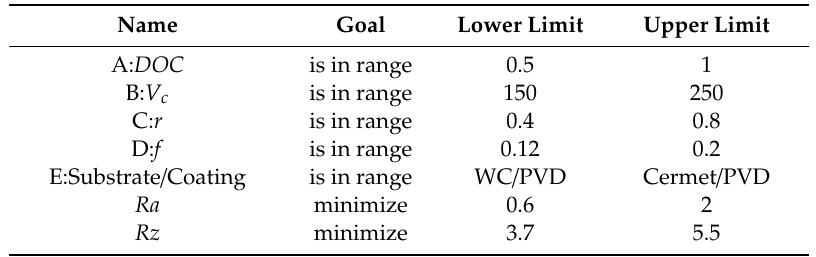
Table 9. Goals and parameter ranges for optimization of Ra and Rz responses.